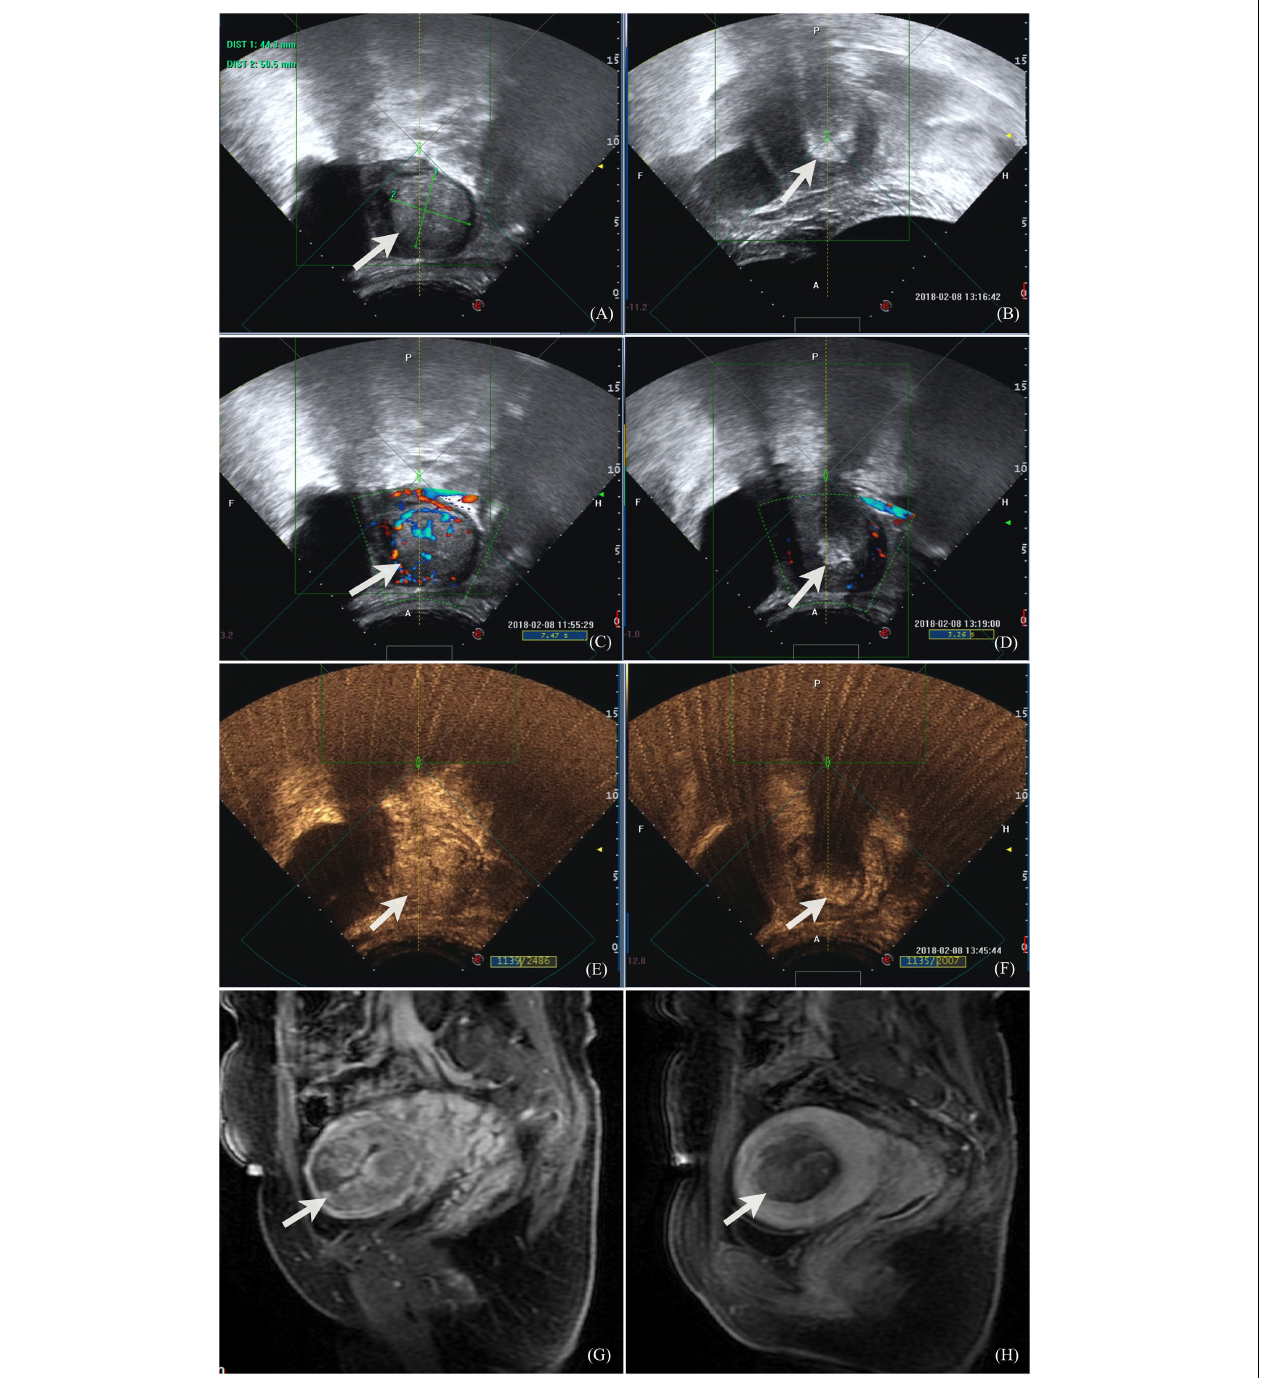
FIGURE 1 | Ultrasound and MR images of a 32-year-old patient with placenta increta. (A) Before HIFU ablation, monitoring ultrasound showed placenta invasion on the fundus-posterior wall of the uterus, about 50.5 × 44.3 mm, with thin myometrium surrounding; (B) during the procedure of HIFU ablation, the monitoring images showed that the target area was clumped with enhanced echo; (C) color Doppler flow imaging showed abundant blood flow signals both in the lesion and surrounding before HIFU ablation; (D) color Doppler flow imaging showed that the grayscale increased in the lesion and no blood flow signal was observed, also peripheral blood flow signal decreased and disappeared after HIFU ablation; (E) contrast-enhanced ultrasound showed that there was abundant blood perfusion in the lesion before HIFU ablation, and there were lacunar areas with less blood flow; (F) contrast-enhanced ultrasound showed that after HIFU ablation, the lesions were covered by grayscale increased images, and the posterior acoustic attenuation was observed. There was no blood perfusion in the lesions, and the boundary between the lesions and the surrounding uterine myometrium was clear; (G) contrast enhanced MR image showed that abnormal signal lesion enhanced in the intrauterine before HIFU and thin myometrium in the fundus of uterus; (H) contrast enhanced MR image 1 day after HIFU showed that the lesion in the uterine cavity was ablated with no blood perfusion.